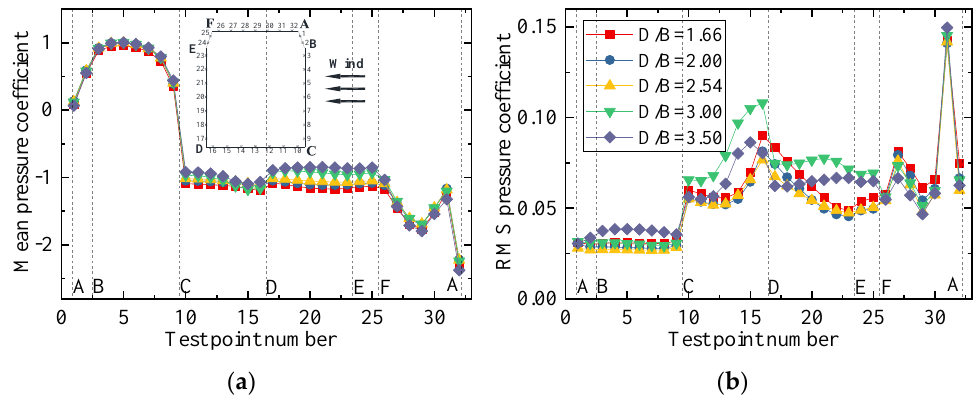
Figure 9. Wind pressure coefficient of the vehicle for various D/B ratios studied in Case 2: ( a ) Mean value; ( b ) RMS value.